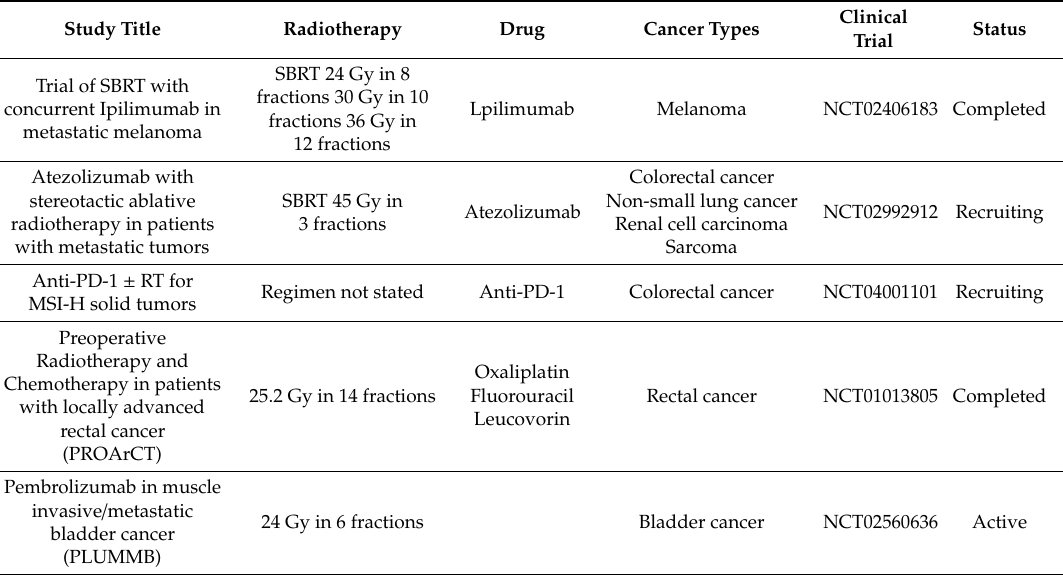
Table 2. Clinical trials of radiation